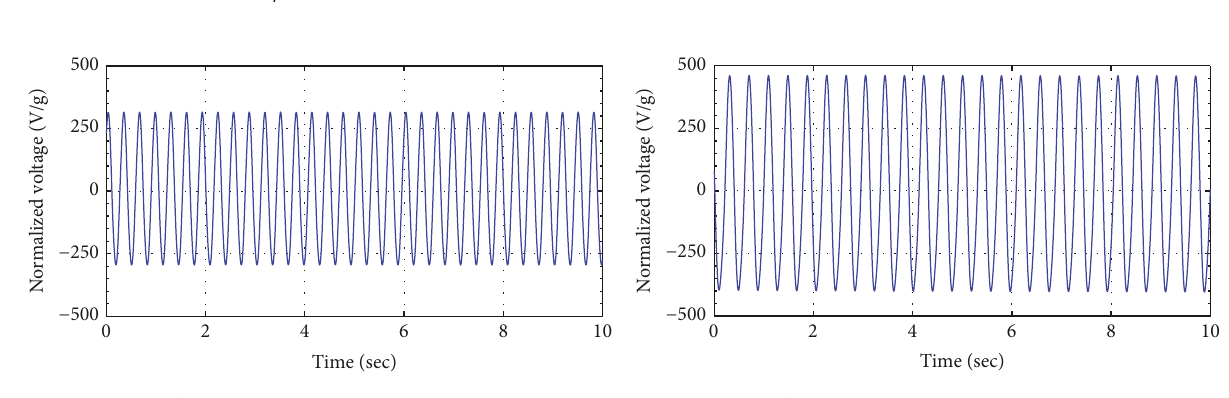
Table 1: Geometric and material parameters of the system. Geometric parameters Piezoceramic Substrate Size (mm) 25 × 40 55 × 40 Thickness (mm) 0.127 0.2 Material parameters Mass density (kg/m 3 )